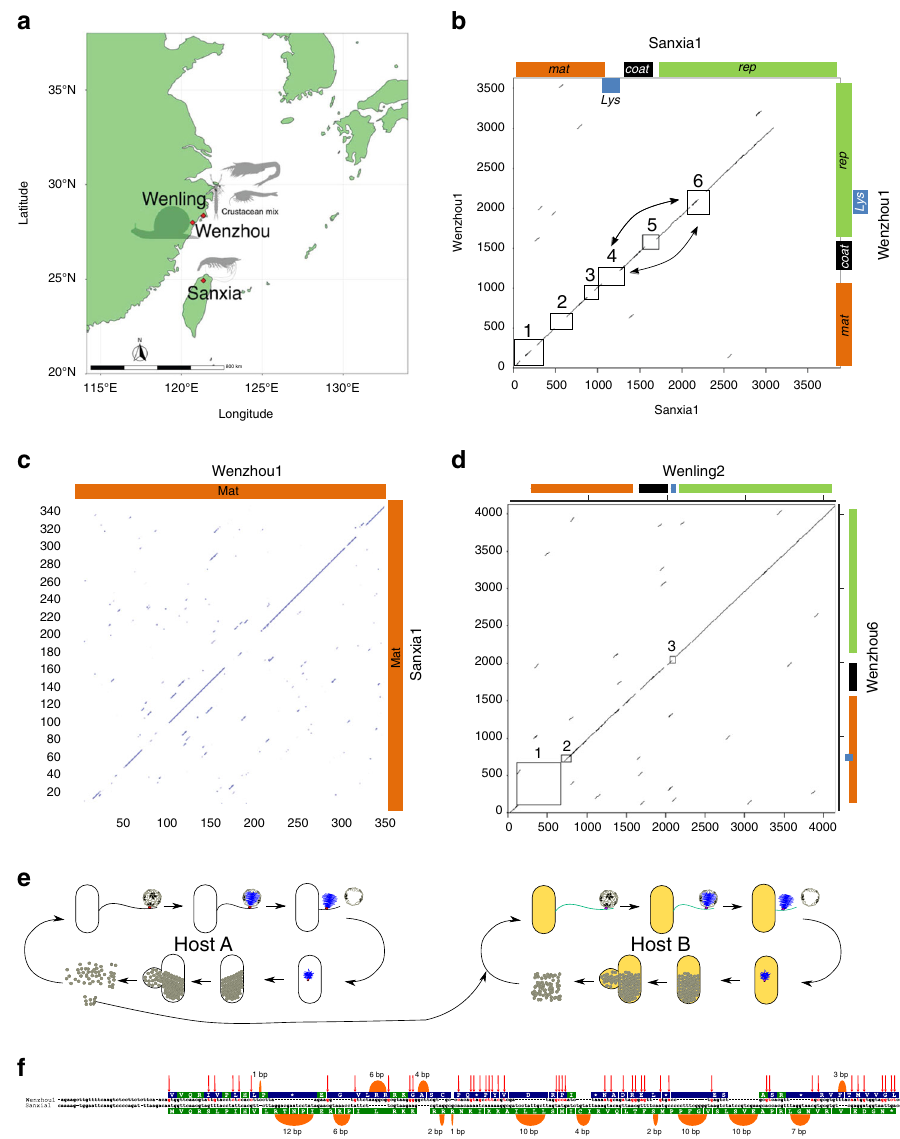
Fig. 6 De novo gene evolution in ssRNA phages sourced from relatively close geographic locations. a Geographic locations and the invertebrate animal sources for the transcriptomes that contained the genomes of Wenzhou1, Wenzhou6, Wengling2, and Sanxia1. Silhouette images were obtained from phylopic. org, courtesy of Christoph Schomburg (shrimp), Joanna Wolfe and T. Michael Keesey (pan-Crustacea), and Scott Hartman (snail) under CC0 1.0 (https:// creativecommons.org/publicdomain/zero/1.0/). b Nucleotide dot plot between Sanxia1 and Wenzhou1 genomes. The gaps in the fi rst ~3000 bases of the alignment are boxed and numbered. Bi-directional arrows indicate the shift in the location of the sgl s. c Dot plot of the maturation protein primary structures of Sanxia1 and Wenzhou1. d Similar to b but Wenzhou6 vs Wenling2 comparison. e Model for de novo lysis gene evolution after changing pili speci fi city and presumably the host. f Sequence alignment of the region represented in box 4 of panel b with base changes highlighted red and indicated with red arrows. The indels are shown as orange loops with the size of the indel indicated above the loops. The translated reading frames are shown above (Wenzhou1) or below (Sanxia1) the nucleotide sequence and the amino acids shared between Sgl Sanxia1 and Wenzhou1 reading frame are colored Gyrotory G76) until the O.D 550 reached 0.2, at which point the cultures were and 50.0, respectively. MIST v3 was used to generate complete NxN plot of related induced with arabinose (0.4% w/v fi nal concentration). Two hours post induction genomes. The code for dotmatcher and MIST tools are available from CPT Galaxy the cultures were harvested and centrifuged for 10 minutes at 10,000 × g at 4 °C. Tools, which is available at https://doi.org/10.5281/zenodo.4048782. The supernatant was fi ltered through 0.22 µm syringe fi lter into a new 50mL falcon tube. At this point 1/10 volume of 3M Sodium acetate pH 5.2 and 1 volume of Multiple sequence alignments (MSA), pair-wise alignments, and phylogenetic isopropanol was added to the fi ltrate, and then passed through a DNA spin column analyses . The MSA, phylogenetic analyses of Mat and Rep primary structures, and (Econospin TM ). The columns were then washed with 2mL of Qiagen PE wash pair-wise alignments of Sgls were done using CLC Genomics Workbench 8.0.1 buffer and bound DNA was eluted in 50 µL of sterile water. Then 5µL of the eluted (Qiagen). The MSAs were done with gap open and extension costs of 10.0 and 1.0, DNA was transformed back into DH5 α T1 R cells and transformants were pooled respectively. Circular cladograms were constructed using Neighbor-Joining method and subjected to another round of plasmid release as described above. The whole and bootstrap analyses with 1000 replicates. process was repeated for a total of two to three rounds. Codon usage (CU) analysis . CU was determined using Measure Independent of Dot plots and multiple interrelated sequence doT (MIST) plots . Nucleotide dot Length and Composition (MILC) method 34 . The CU analyses were done using an plots were generated with dotmatcher 33 with window size and threshold set at 40.0